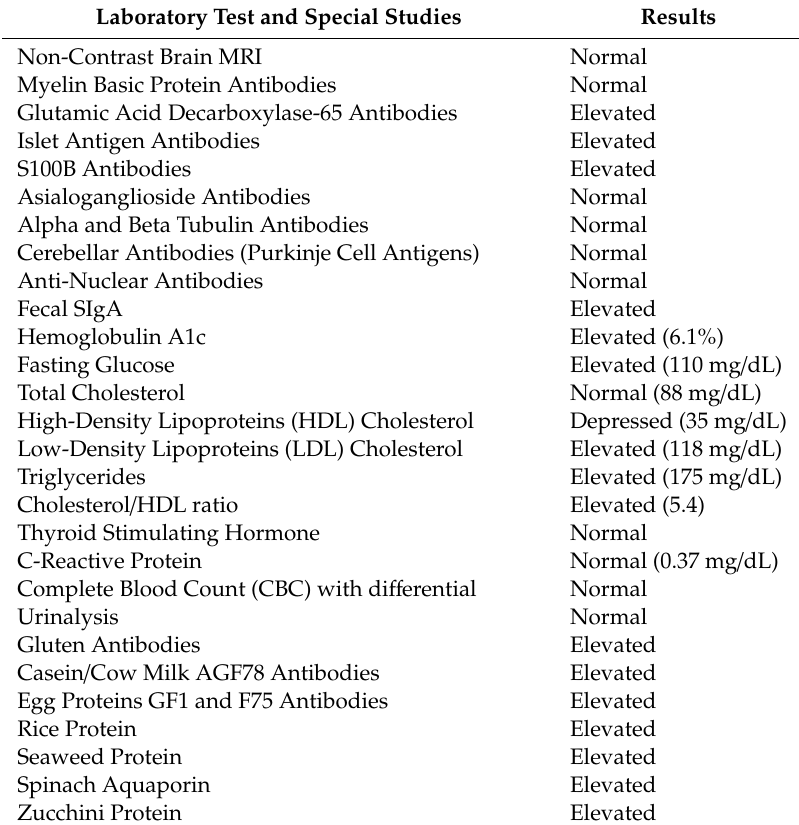
Table 1. Patients test results during presentation of chief